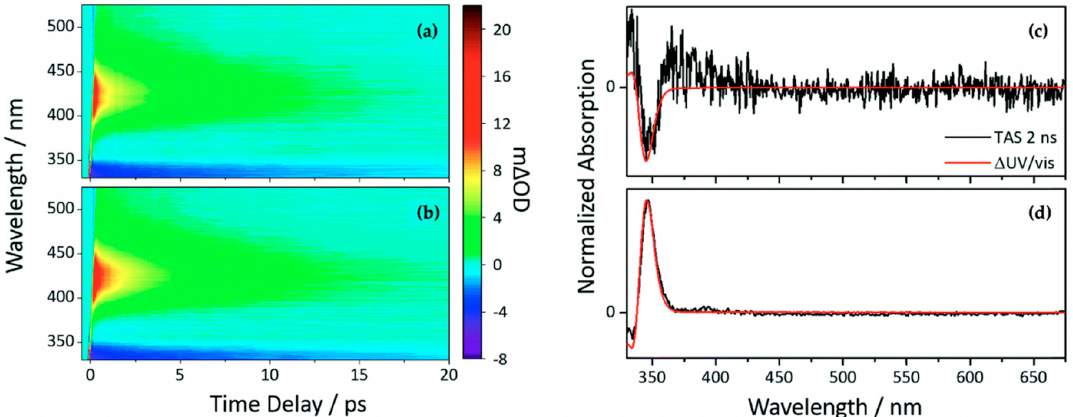
Figure 7. TAS displayed as false colour maps of ( a ) cis -ES and ( b ) trans -ES in cyclohexane photoexcited at 319 nm. Plot to show the TAS taken at ∆ t = 2 ns of ( c ) cis -ES and ( d ) trans -ES overlaid with ∆ UV / visible spectra. Reproduced and adapted with permission from [114], licensed under CC BY 3.0. Published by the Royal Society of Chemistry.